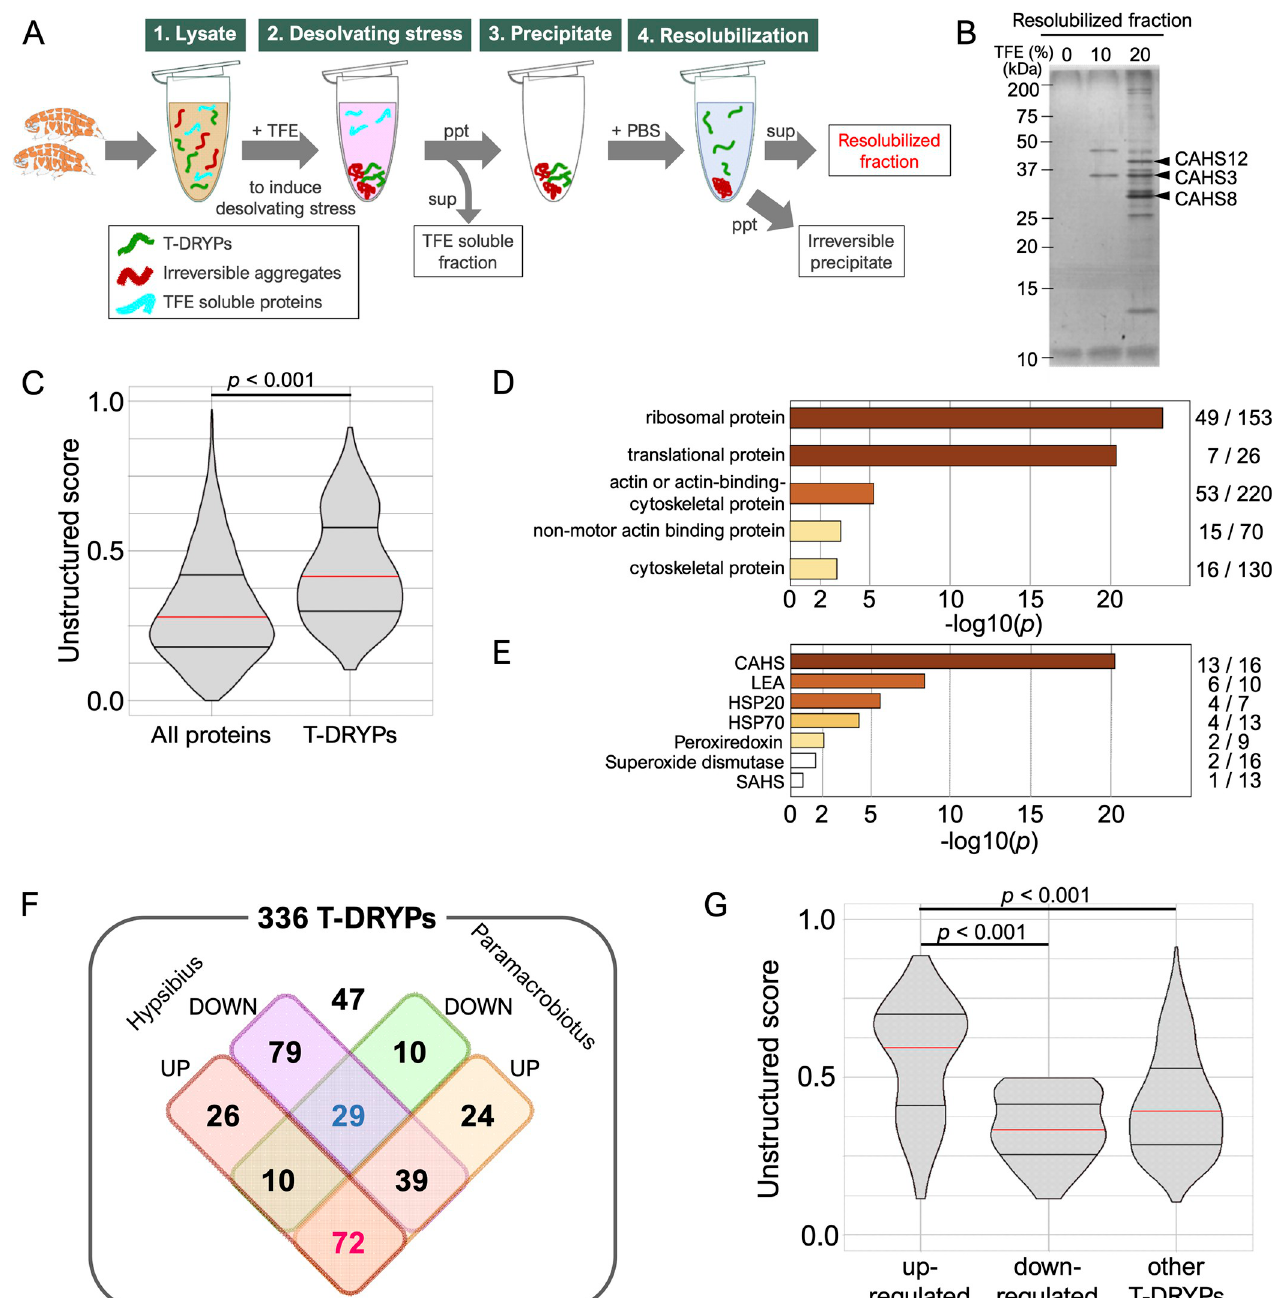
Fig 1. Isolation and characterization of T-DRYPs. AU : AbbreviationlistshavebeencompiledforthoseusedinFigs 1 (cid:0) 4 : Pleaseverifythatallentriesarecorrect : (A) Experimental scheme of T-DRYP isolation from tardigrade lysate. (B) SDS-PAGE image of the resolubilized fractions with 0%, 10%, or 20% TFE treatment. (C) Comparison of the unstructured score distributions between all tardigrade proteins and T-DRYPs. (D) Enrichment analysis of the PANTHER protein class in T-DRYPs. Ribosomal proteins and cytoskeletal proteins were significantly enriched. The numbers of the corresponding proteins detected in T-DRYPs and all tardigrade proteomes are shown on the right, respectively. (E) Enrichment analysis of stress-related proteins in T-DRYPs. CAHS proteins were significantly enriched in T-DRYPs. (F) Venn diagram of T-DRYPs classified by up- or down- regulation upon desiccation in orthologs of 2 other tardigrade species. (G) Comparison of unstructured score distributions among the differently regulated protein groups in T-DRYPs. “Up-regulated” and “down-regulated” indicate up-regulated or down-regulated proteins in both species, respectively. Proteins up- regulated upon desiccation exhibited higher unstructured scores. Red and 2 black horizontal bars in violin plot indicate the 50th, 25th, and 75th percentiles, respectively. Statistical analyses were performed with the Wilcoxon rank sum test in (C) and the Steel–Dwass test in (G). The underlying numerical data are available in S4 Data (C, D, and G) in S2 Data (E) and in S1 Data (F). CAHS, cytoplasmic-abundant heat-soluble; T-DRYP, TFE-dependent reversibly condensing protein; TFE,